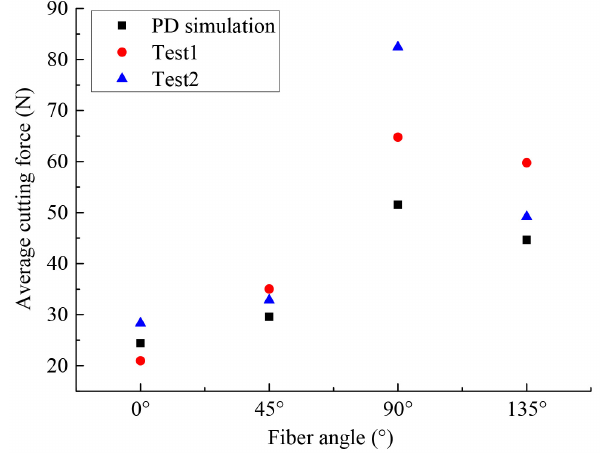
Figure 12. Average cutting force for different fiber